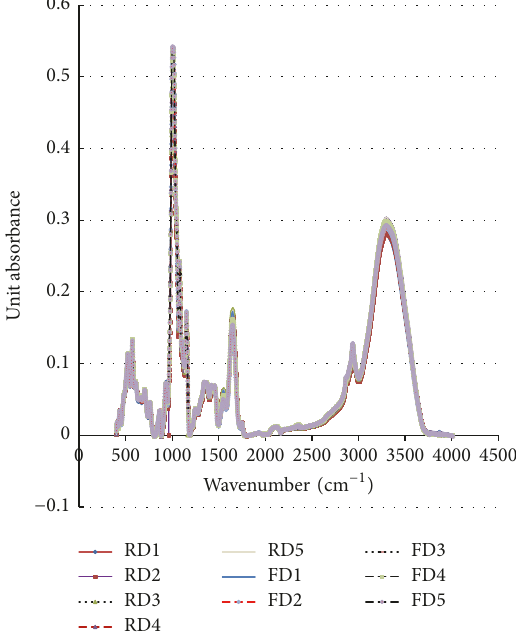
Figure 9: Mean spectra of the normalized bread spectra over 5 days of storage for room and frozen conditions.